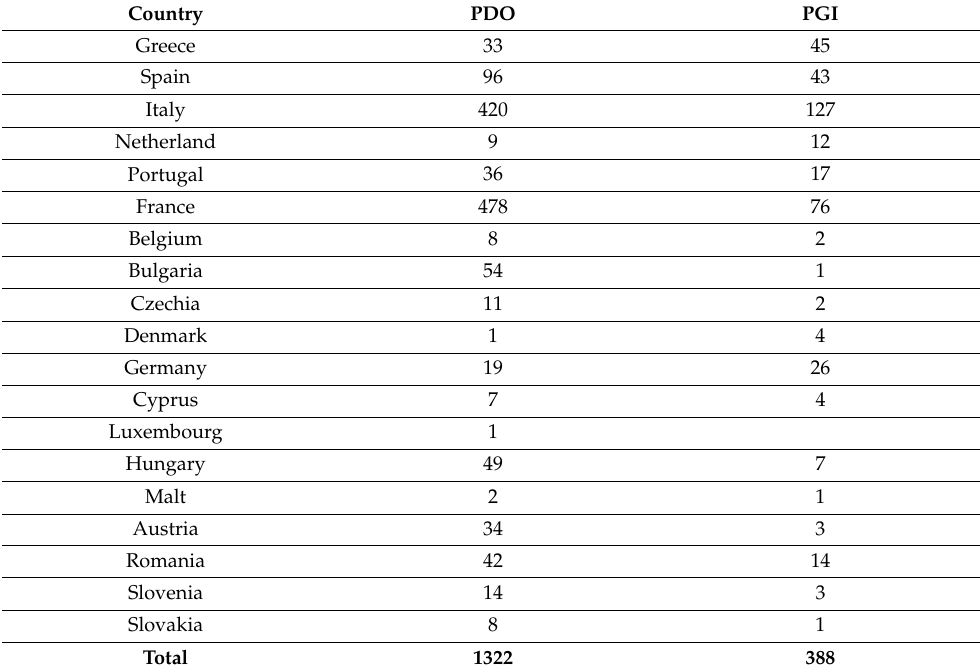
Table 2. Protected designations of origin and protected geographical indications for wine in the European Union (2021).